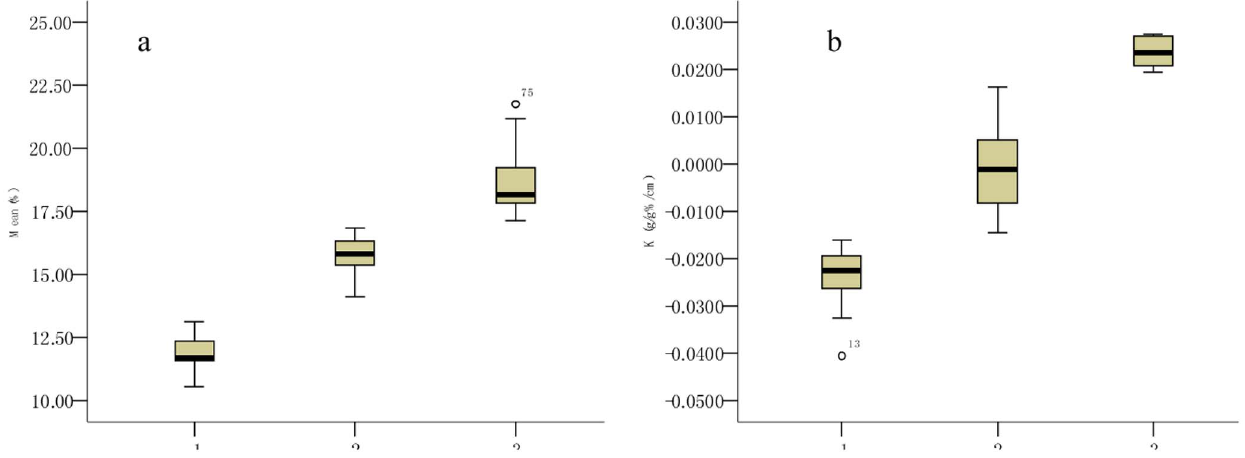
Figure 5. Grouping of 101 vertical soil water profiles in the Sanyanjing catchment before the rainy season by cluster analysis of the mean value (a) and regression gradient (K, b).